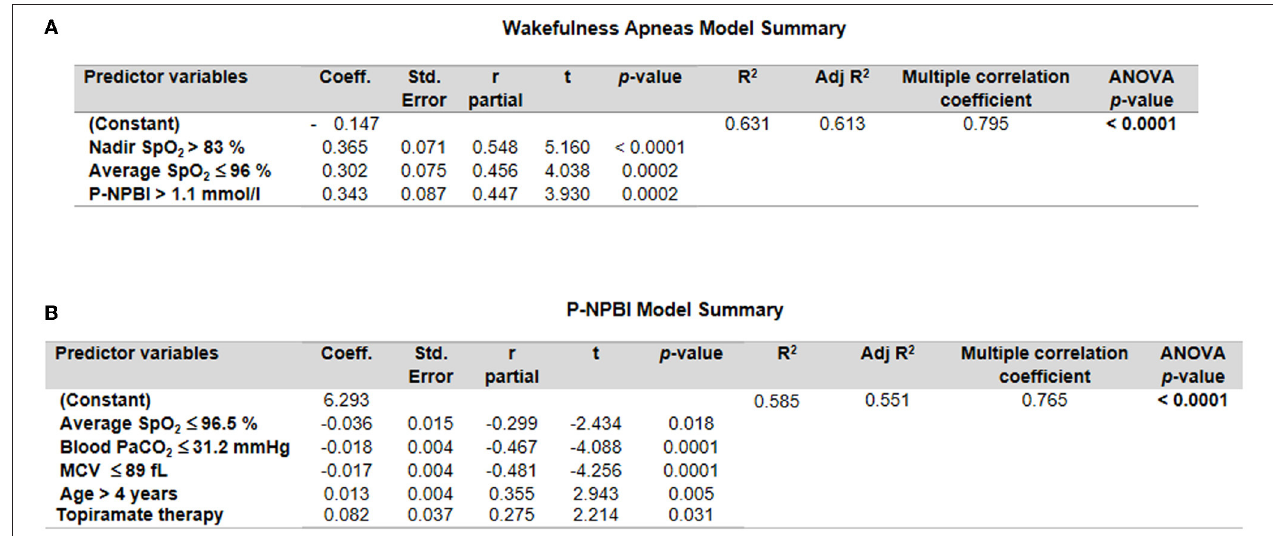
FIGURE 7 | Multiple stepwise regression analysis models for (A) wakefulness apneas and (B) P-NPBI as dependent variables in the examined patients with RTT. Cut-off values were calculated by ROC curve analysis.